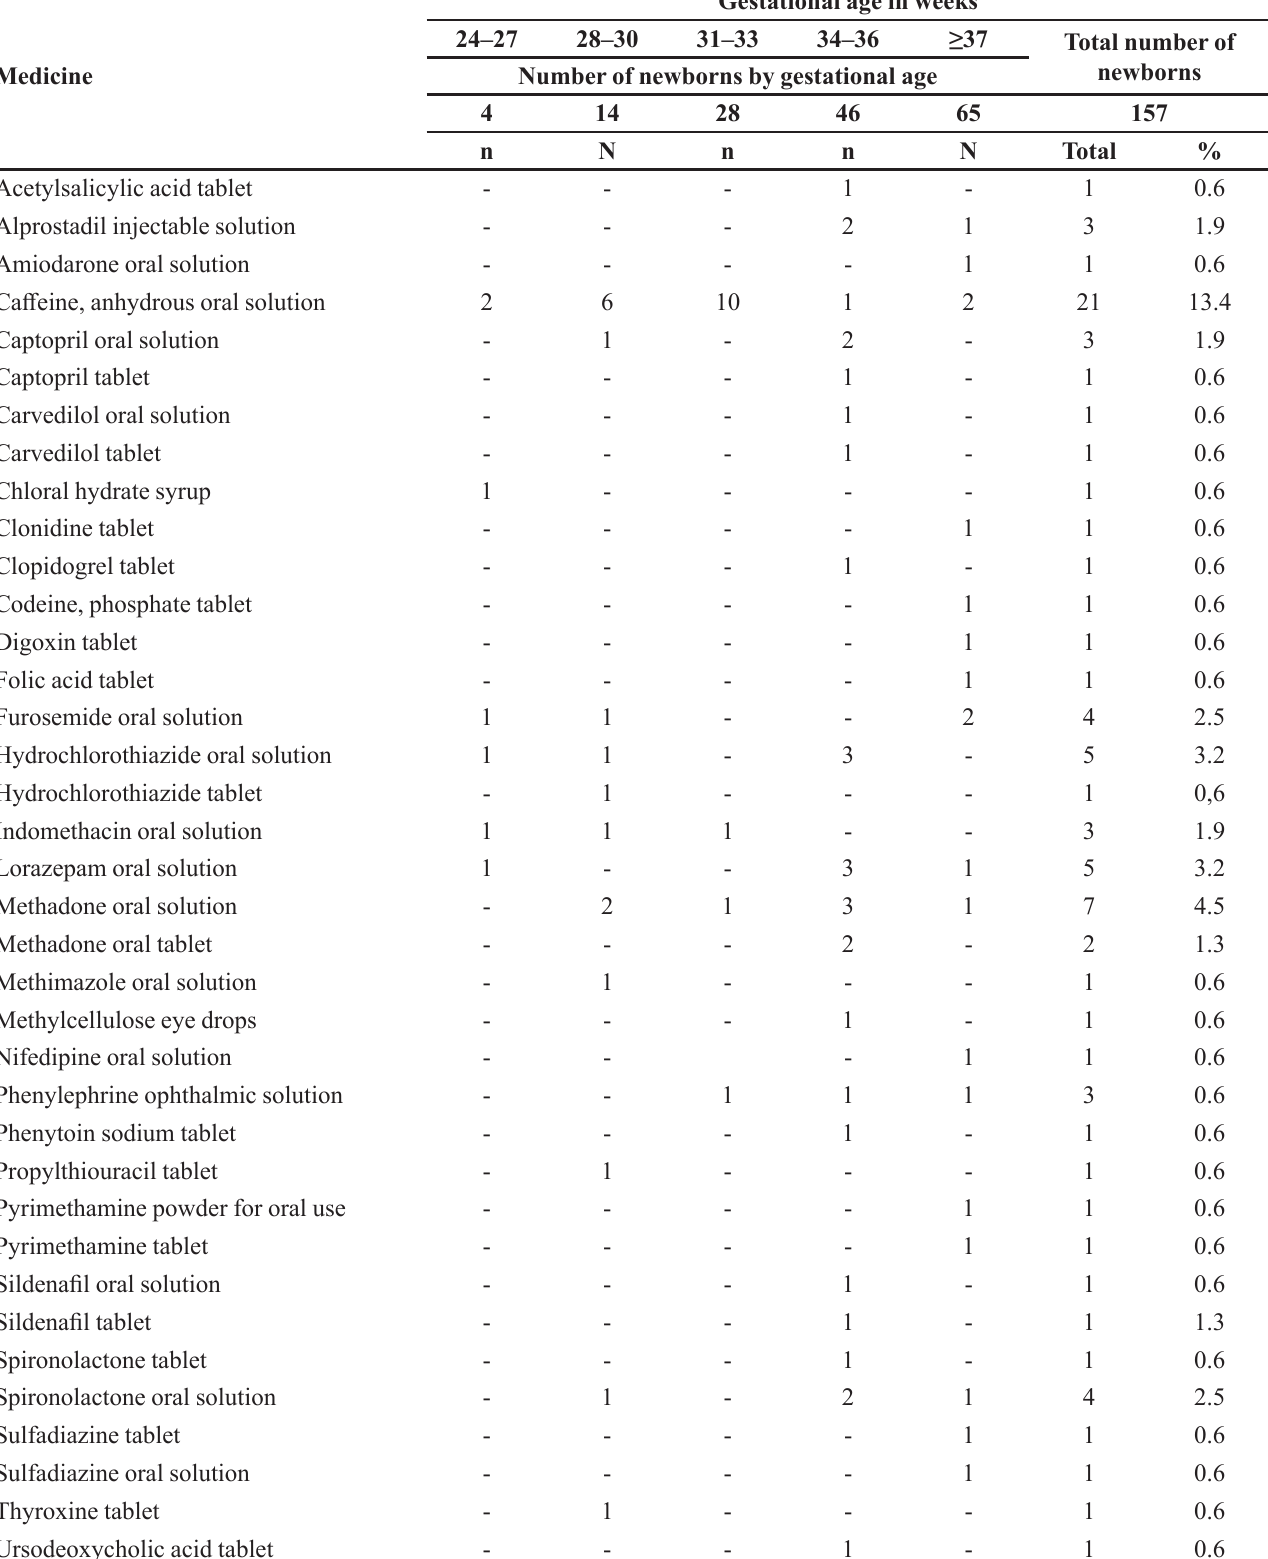
TABLE IV - Frequency of newborns administered unlicensed ANVISA medicines by gestational age in weeks